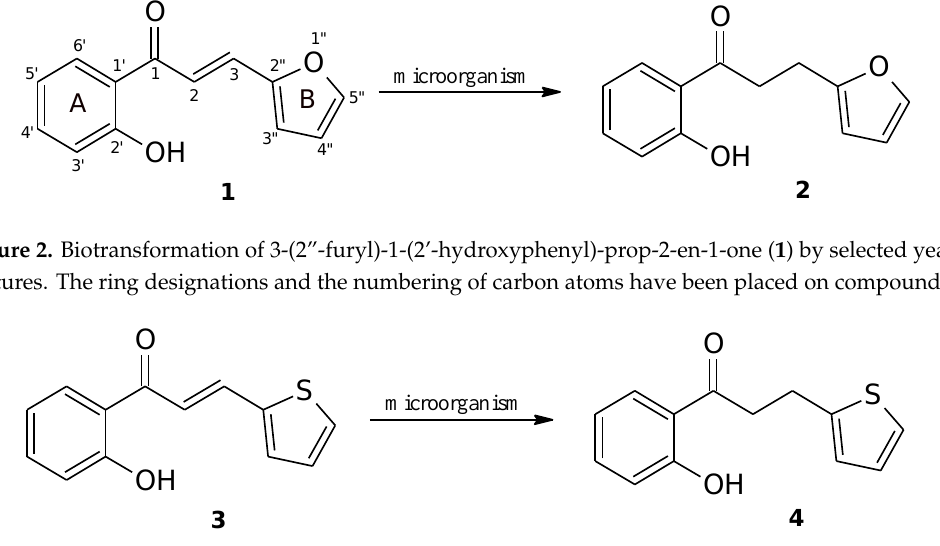
Figure 3. Biotransformation of 3-(2”-thienyl)-1-(2’-hydroxyphenyl)-prop-2-en-1-one ( 3 ) by selected yeast cultures.